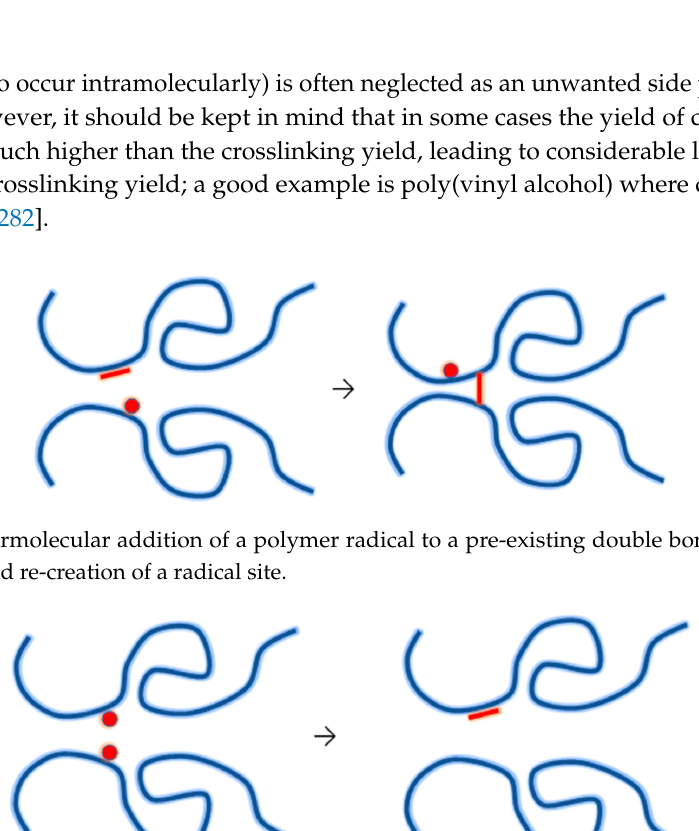
Figure 17. H-transfer leading to a shift in location of the radical along a polymer chain.